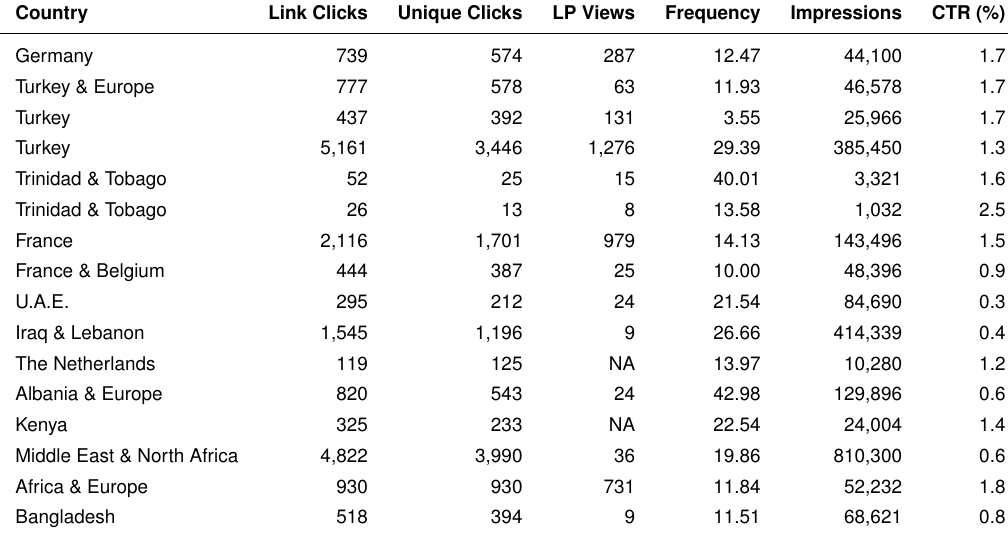
Table 7. Overview of results.